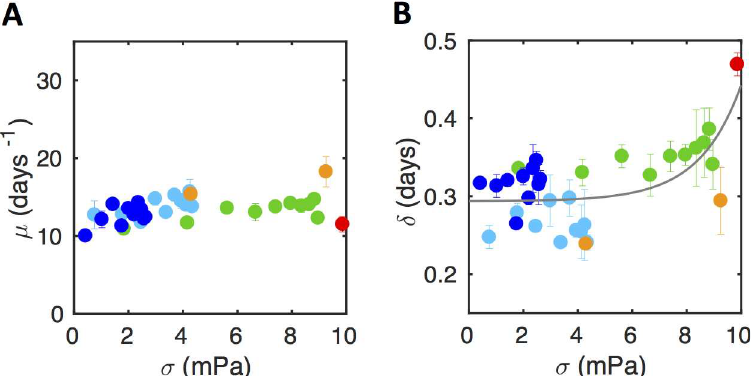
Fig 4. Below 10 mPa, shear stressdoes not affect biofilm growth rate, but impacts apparent lag time. (A) Biofilm growth rate, μ (as derived from the exponential adjustment, see Fig 3) as a function of bottom shear stress. (B) The apparentlag time, δ , increasesas a function of shear stress; experimental data (solid colored dots) can be adjustedusing an exponential law (grey line). Data were collectedfrom biofilm growingin the low shear stress regime, i.e. at σ < 10 mPa. Data are represented using the same channelcolor code as in Fig 1. Means and SDs over two positionsare represented. Plot of a representative experiment of at least three (see data statistical dispersion in S1